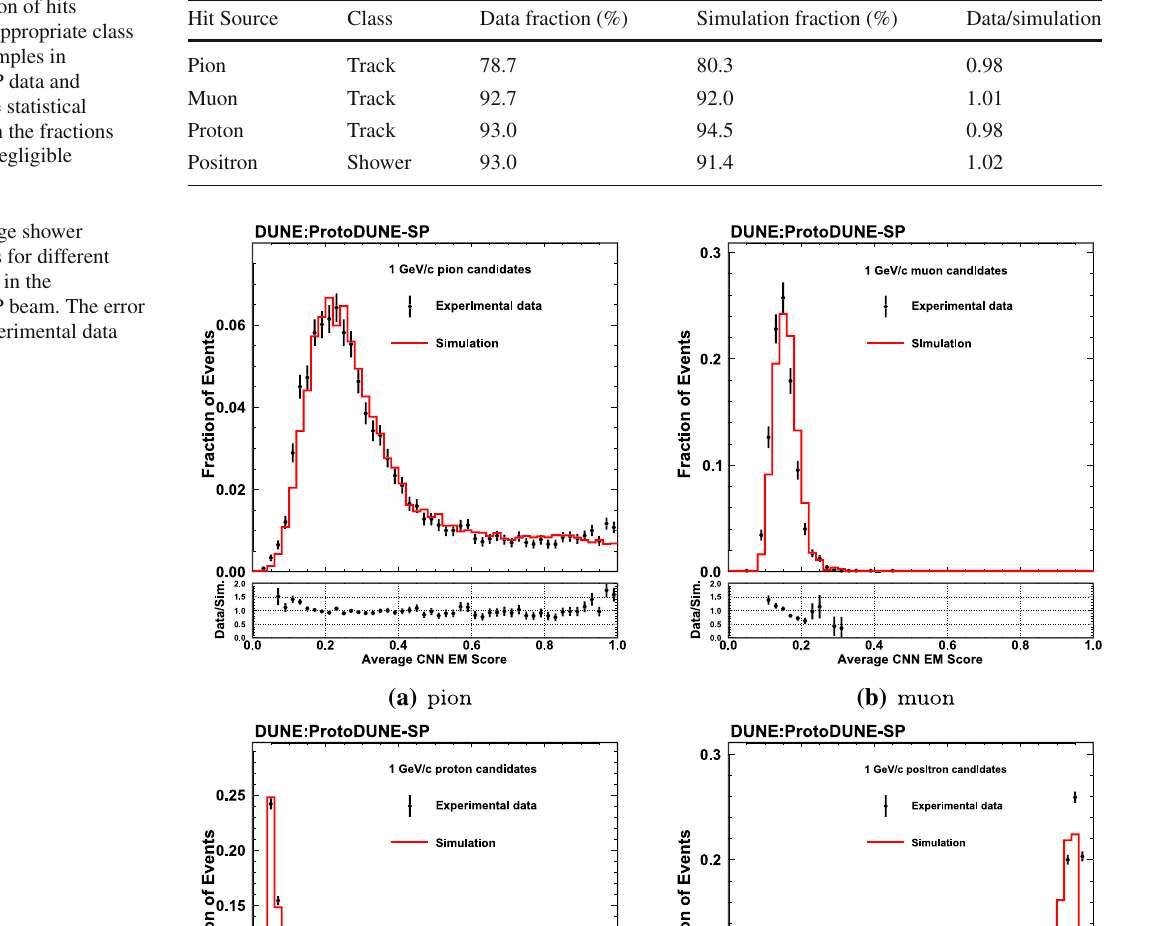
classified into appropriate class for different samples in ProtoDUNE-SP data and simulation. The statistical uncertainties on the fractions and ratios are negligible